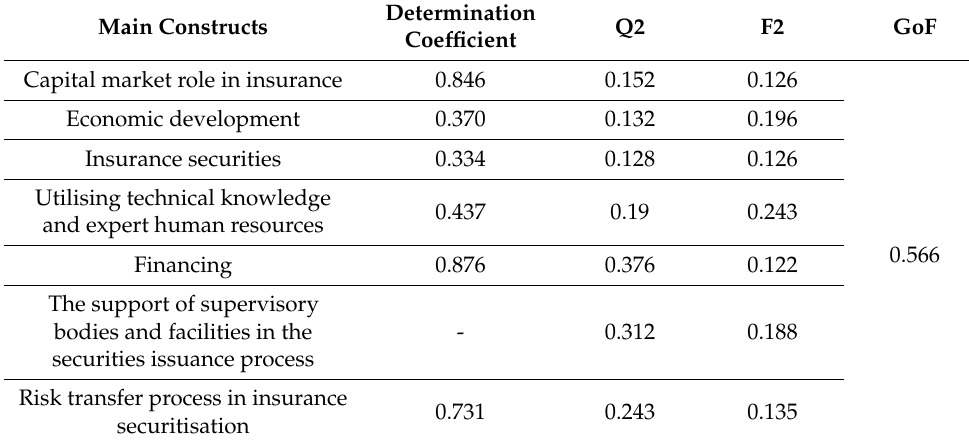
Table 5. The summary of the evaluation results of the model structure